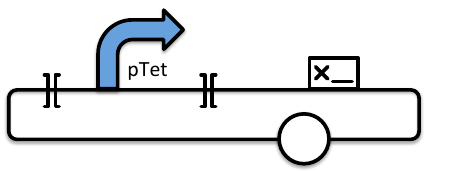
Figure 27: Promoter stored in a plasmid as in Figure 26, except that the restriction sites before and after the promoter are blunt-end.